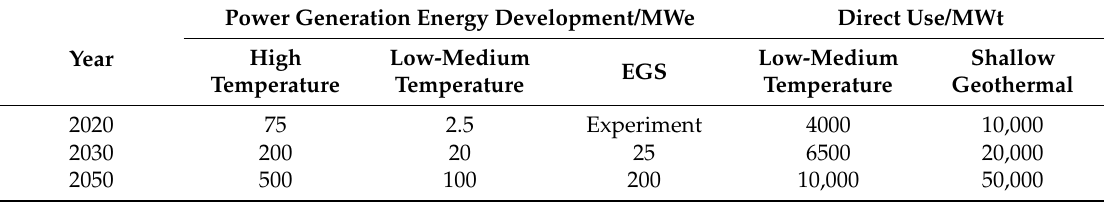
Table 3. Strategic targets of geothermal energy development in China [3,32].